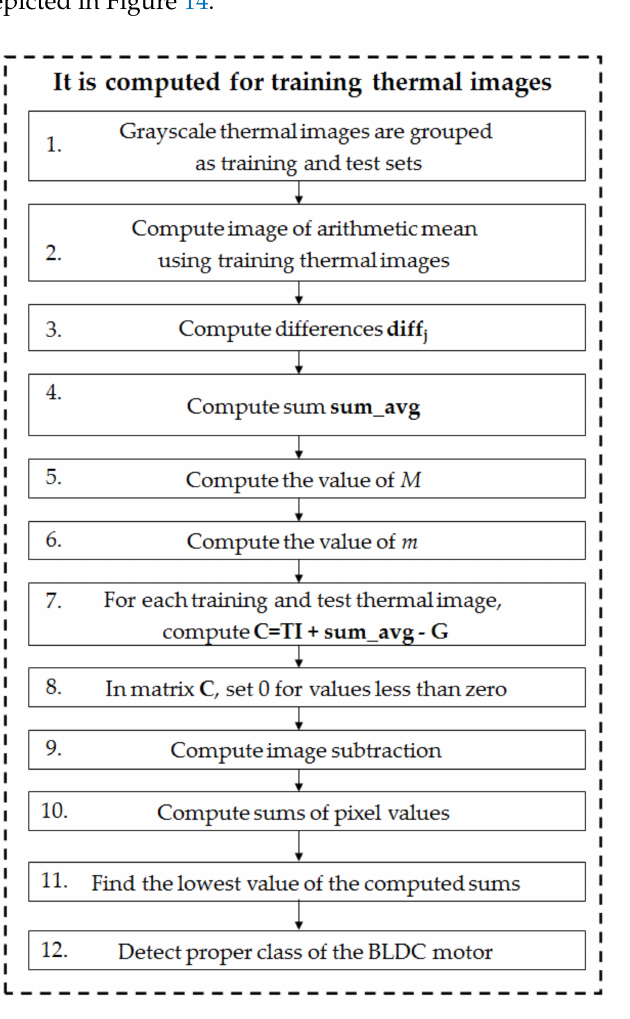
Figure 14. Flowchart of processing using the CPoAMoTI method. Images of arithmetic means of 4 analyzed classes: class 1 , class 2 , class 3 , class 4 are presented in Figure